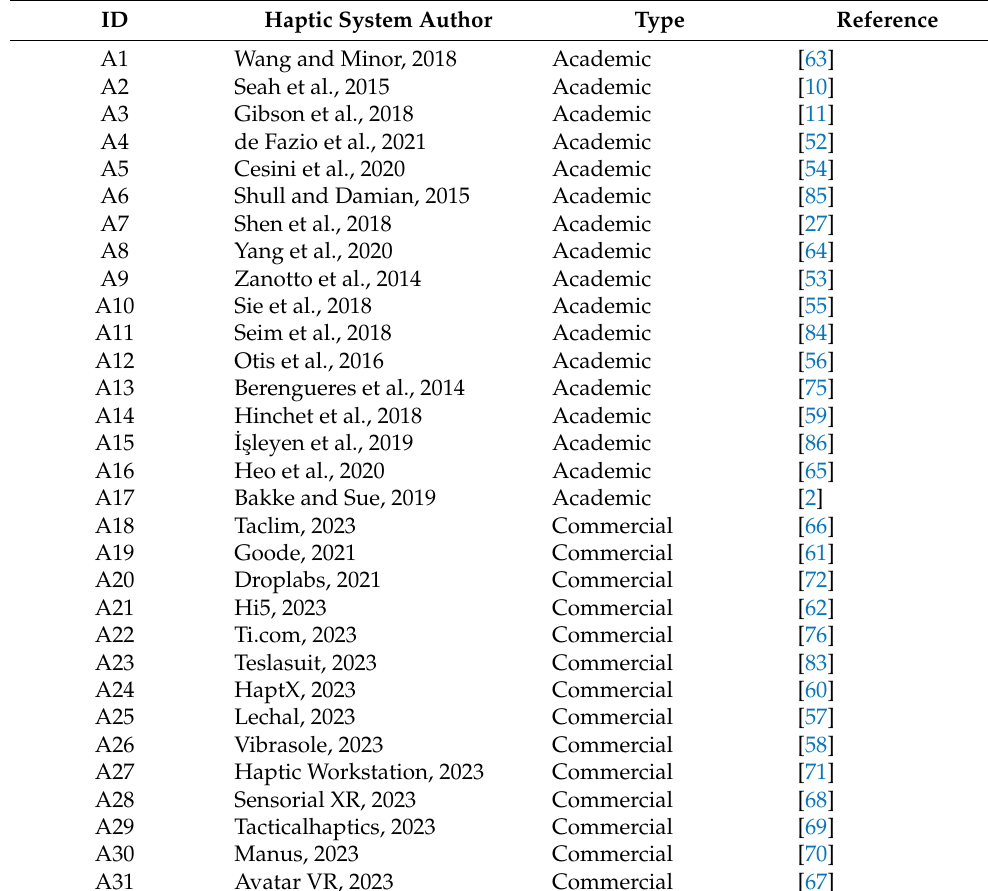
Table A1. The selected haptic systems referred to in this